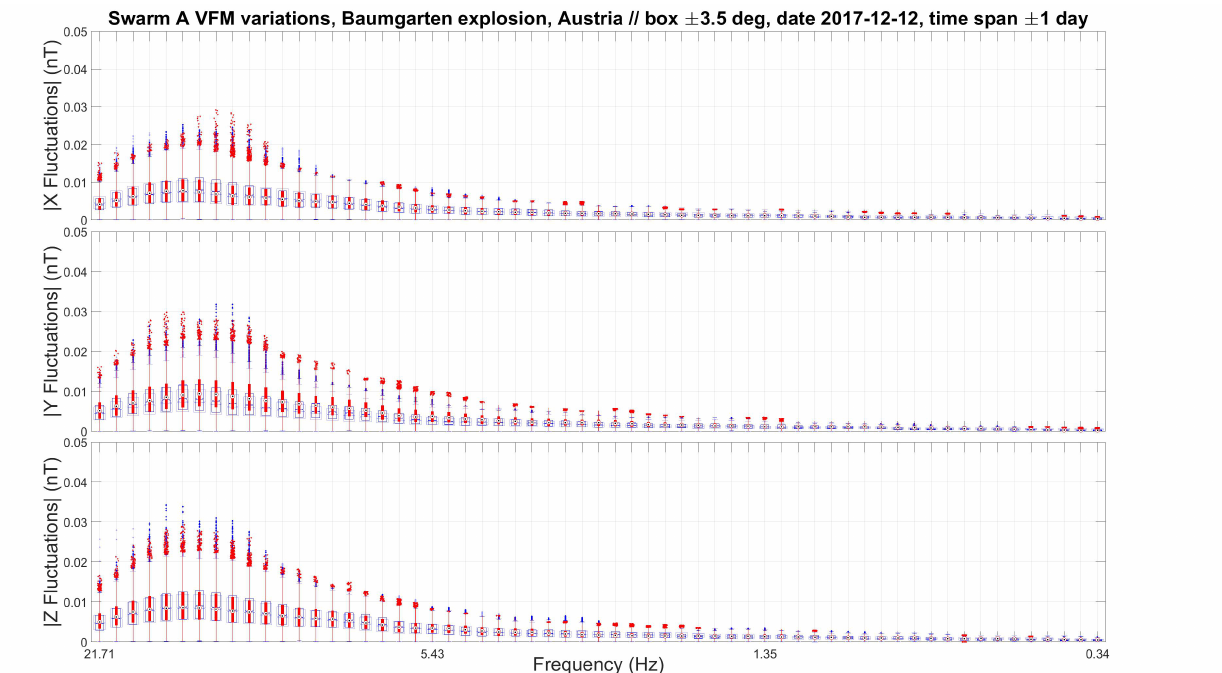
Figure 7. Distribution of Swarm A VFM magnetic field fluctuations grouped in individual frequency bands for the explosion (2017-12-12T07:45 UTC) in Baumgarten, Austria. The colour coding is the same as in Figure 2, the geomagnetic activity is | Dst | ≤ 29 nT for the selected time